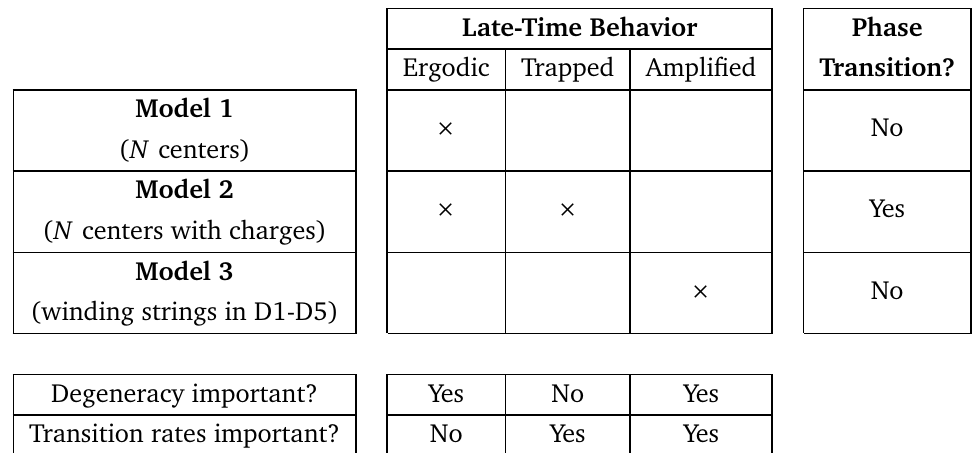
Table 1: Summary of our main results for the late-time behavior of each microstate